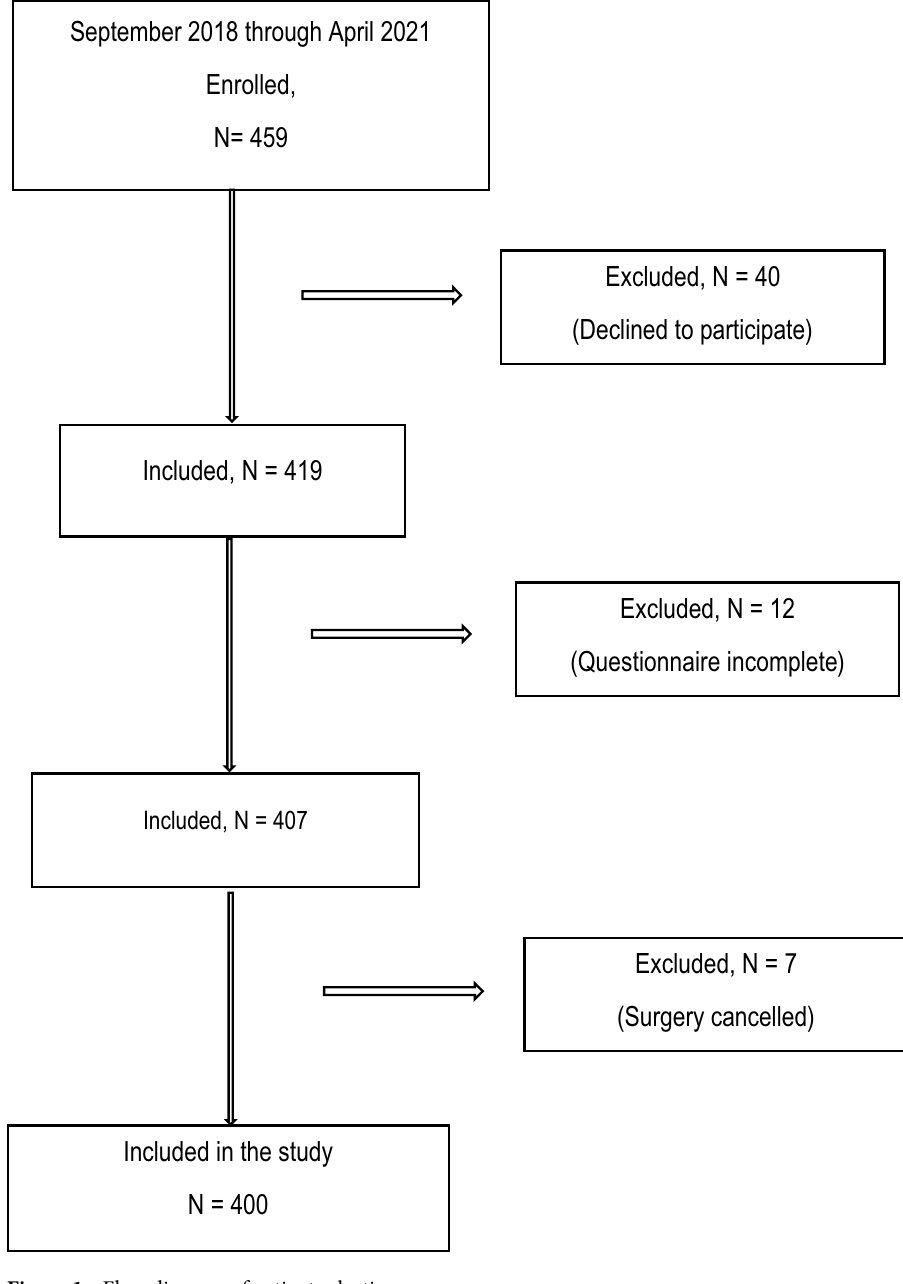
Figure 1. Flow diagram of patient